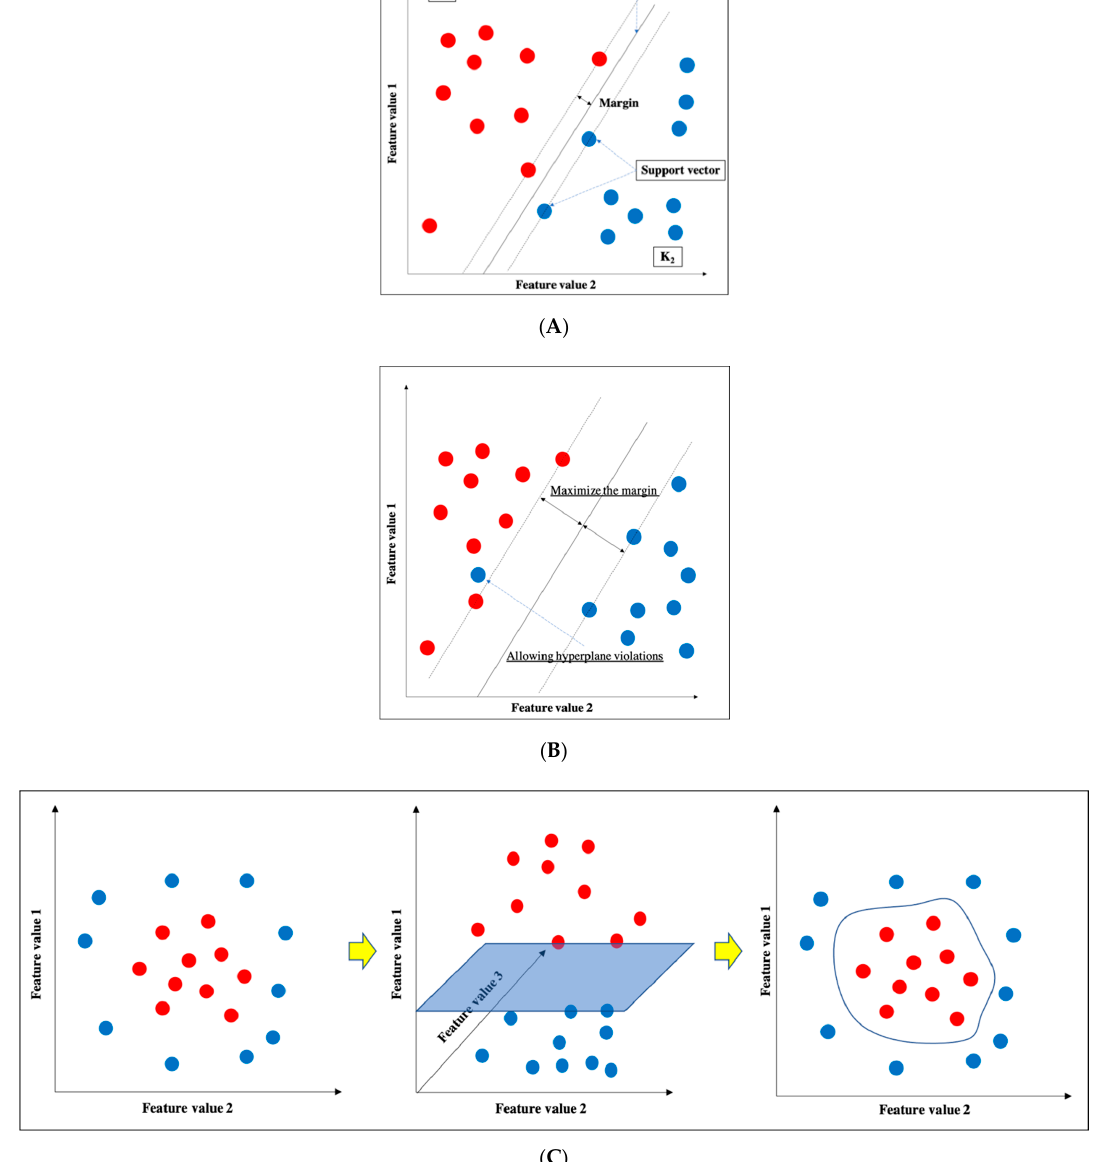
Figure 3. Support vector machine (SVM). ( A ) Basic structure of SVM. ( B ) Soft-margin SVM. ( C ) Kernel